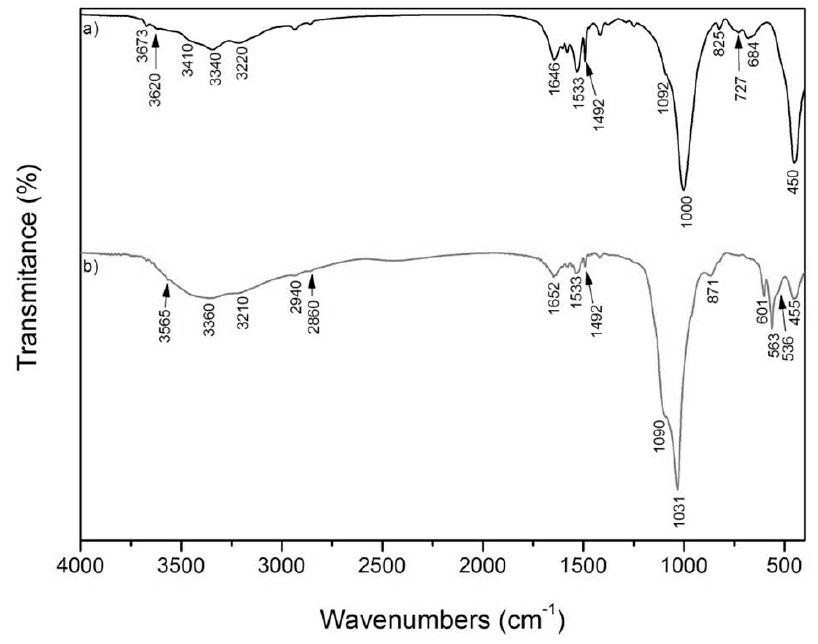
Figure 4. FTIR spectra of: ( a ) VCA and ( b ) VCAH.